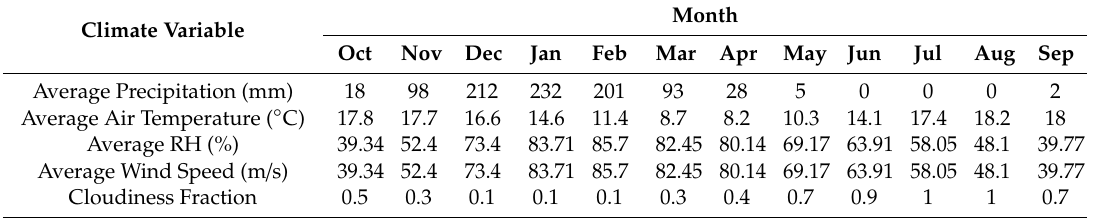
Table 2. Averaged monthly climate values of Chongwe River catchment (1965 to